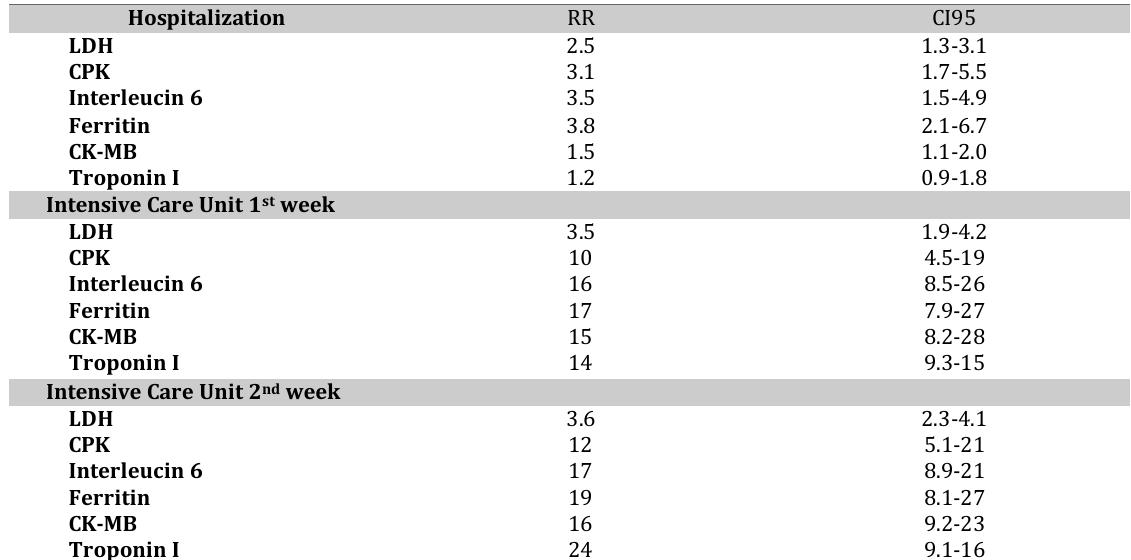
Table 3. Mortality risk from inflammatory and tissue injury biomarkers